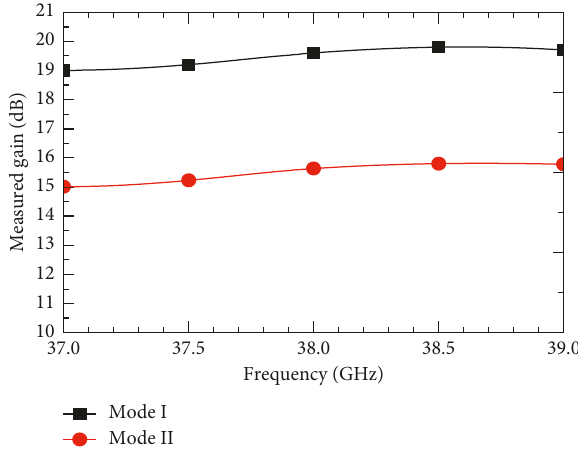
Figure 11: Measured peak gains of the subarray, with the main beam being in θ � 0 ° .